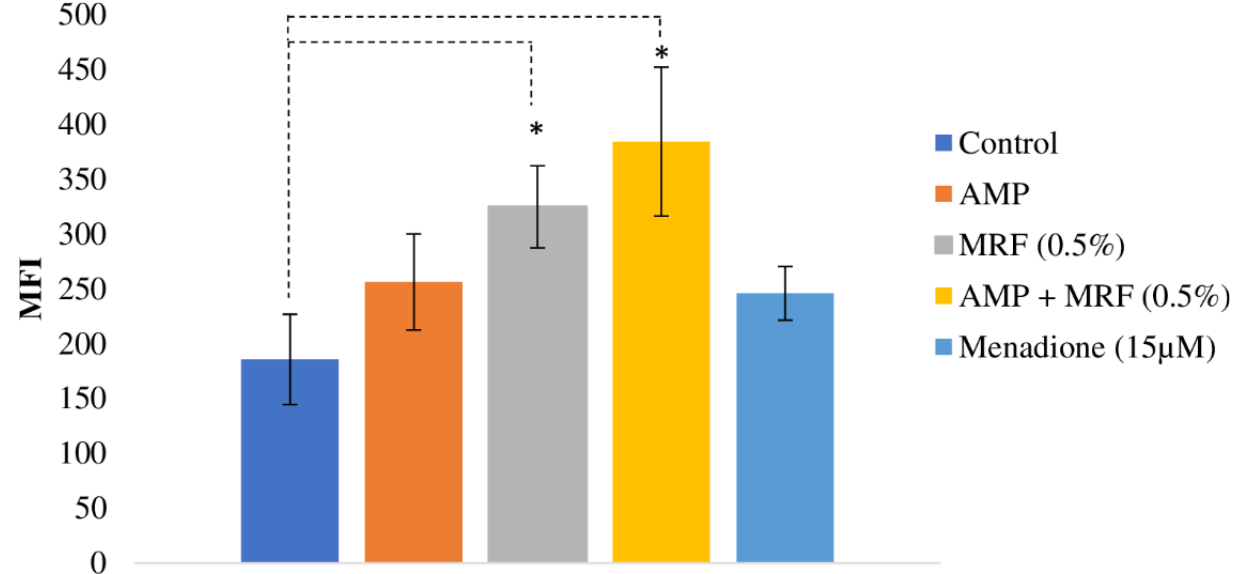
Figure 1. The effect of MRF on ROS production in antibiotic-resistant E. coli with and without antibiotic treatment. Diagram displays mean fluorescent intensity (MFI/OD595nm) of antibiotic-resistant E. coli. Antibiotic-resistant E. coli treated with 5 mgmL − 1 ampicillin (AMP). Standard deviation is represented by error bars ( n = 6). Means that were significantly different to the control are marked with an asterisk (*) ( p ≤ 0.01, ANOVA, Fisher-LSD).